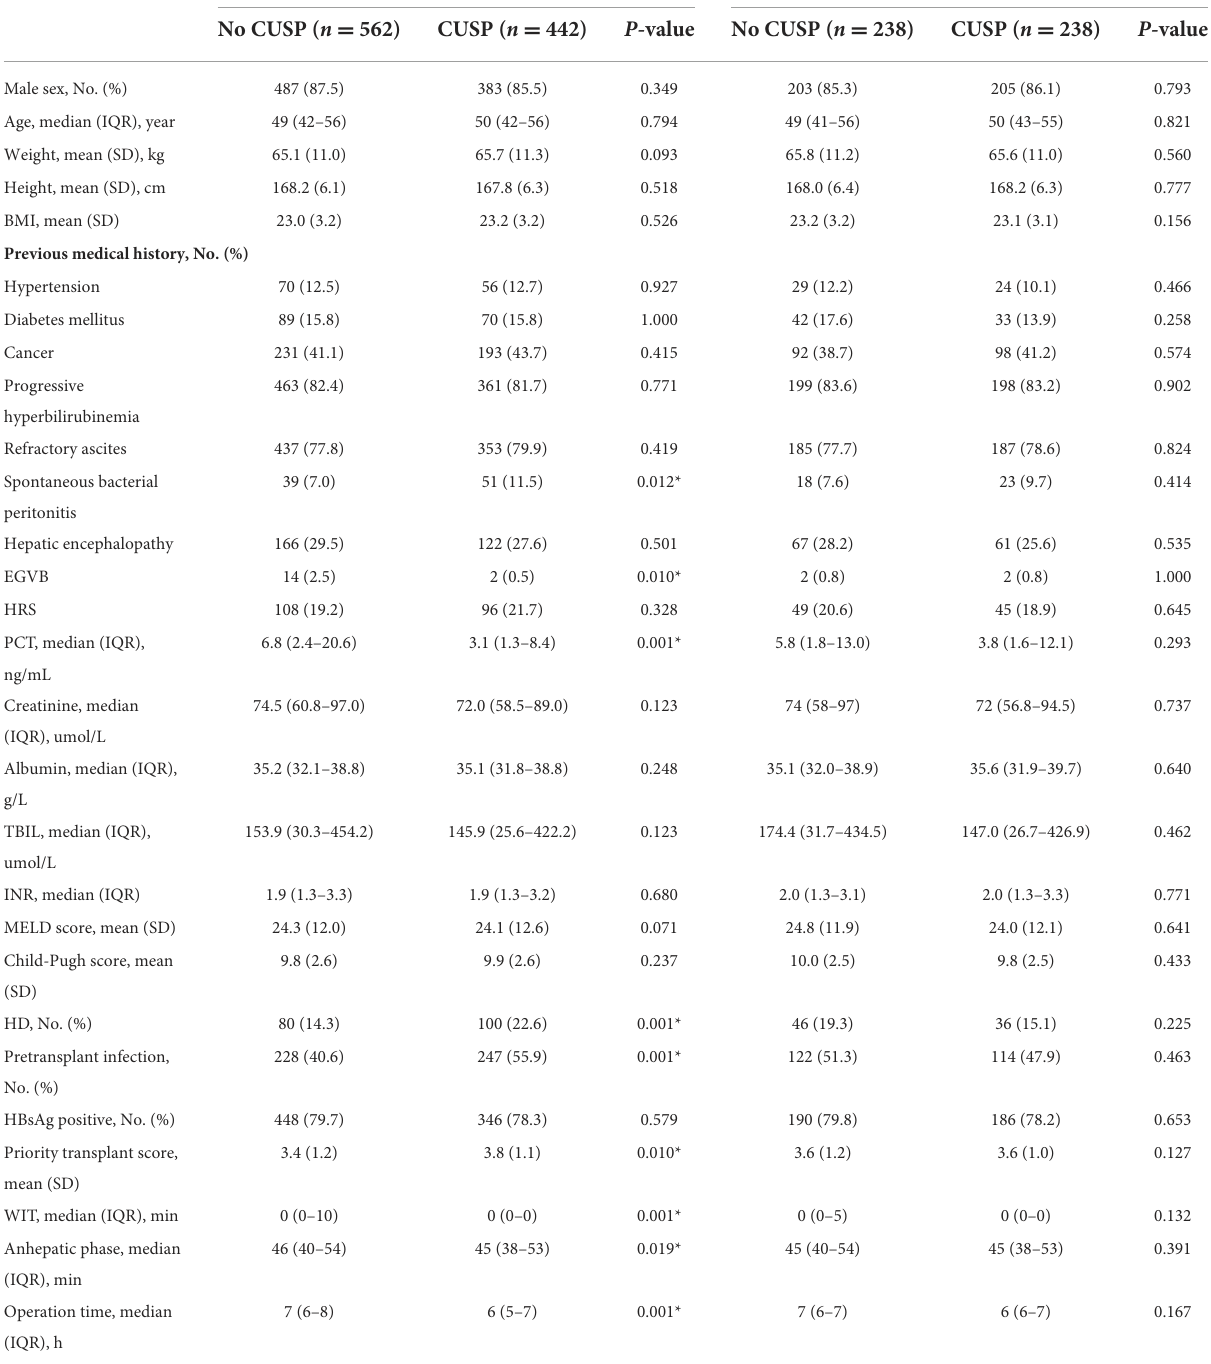
TABLE 1 Baseline characteristics of no CUSP group and CUSP group in the TICU